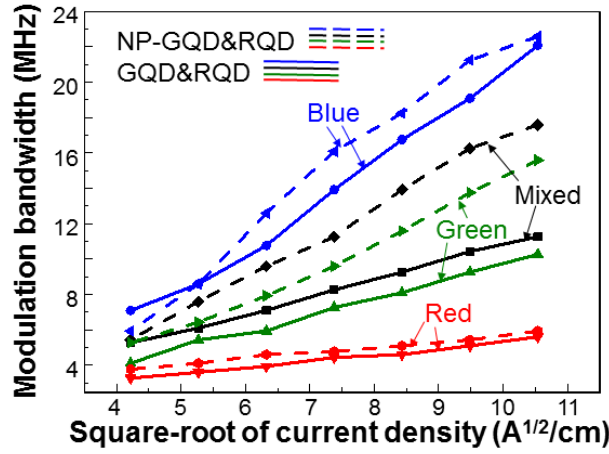
Figure 10. MBs of blue, green, red, and mixed lights in samples GQD&RQD (continuous curves) and NP-GQD&RQD (dashed curves) as functions of the square root of injected current density.